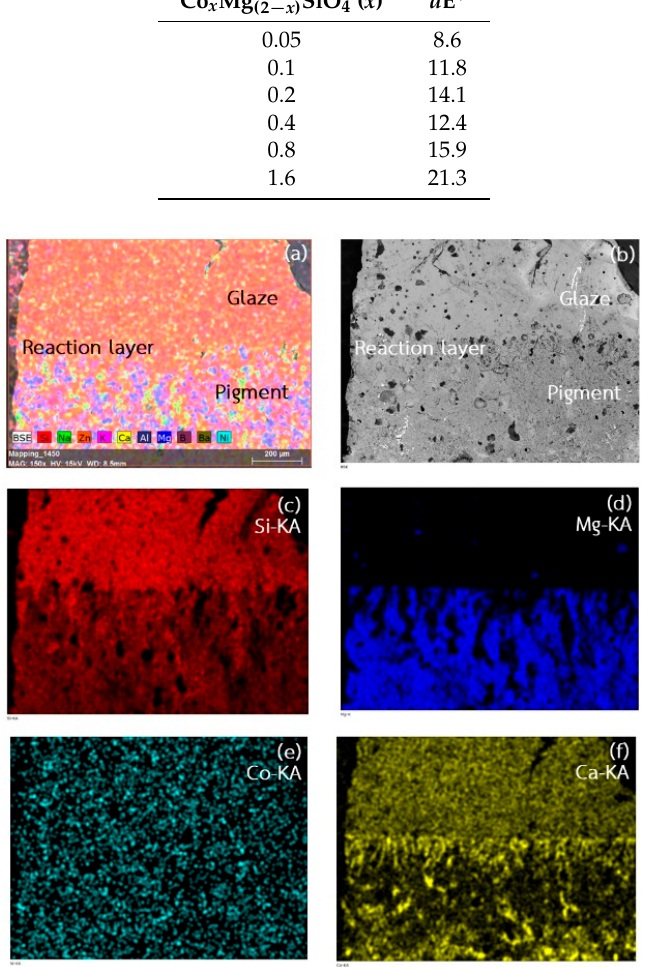
Figure 9. EDS mapping of the interface between Co 0.1 Mg 1.9 SiO 4 pigment and low-temperature glaze: ( a ) existing elements; ( b ) morphology of inter-layer between pigment and glaze; ( c ) silicon; ( d ) magnesium; ( e ) cobalt; and ( f ) calcium.